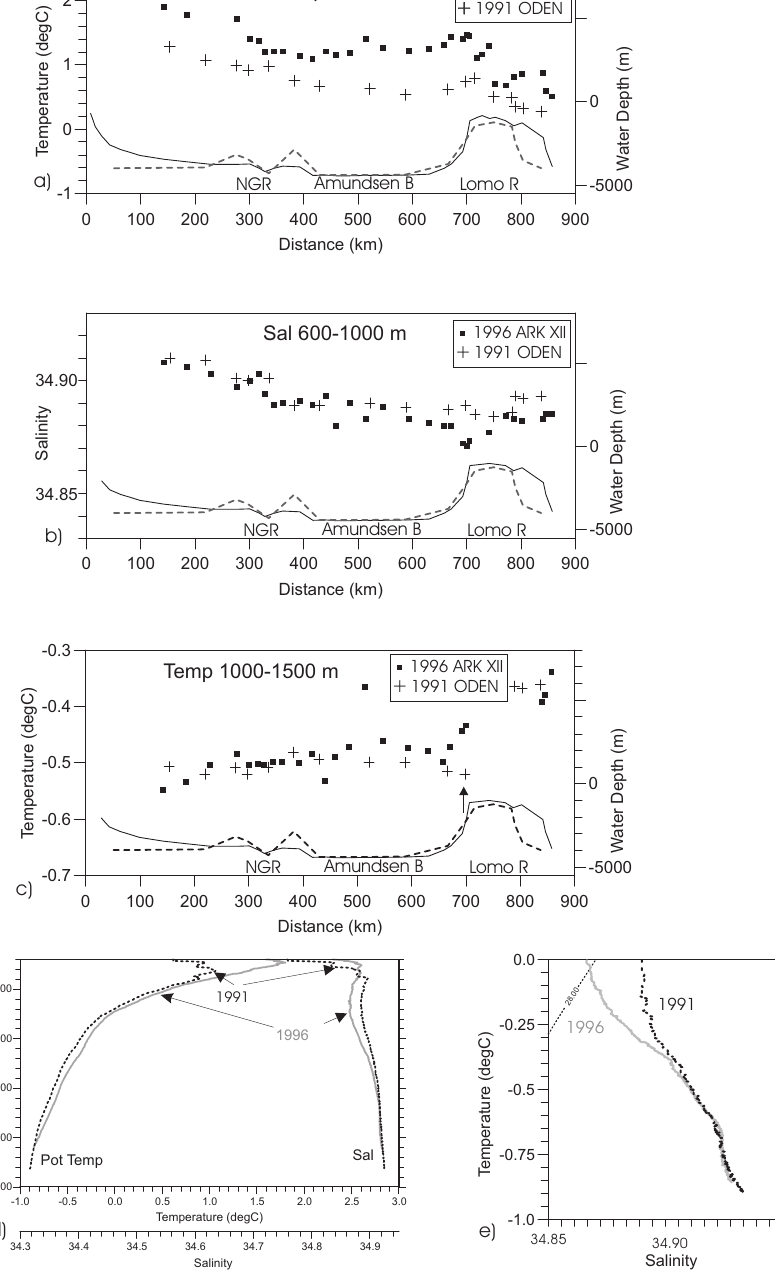
Fig. 15. Cross-basin distribution of vertically averaged values from the Nansen Gakkel Ridge (NGR) through the Amundsen Basin and over the Lomonosov Ridge (Lomo R) into the Makarov Basin along a section oc- cupied by Oden in 1991 and during ARKXII in 1996 (Fig. 1 for location): (a) temperature of the Fram Strait At- lantic layer (150–400m), (b) salinity of the core of the Barents Sea layer (600– 1000m), (c) temperature between 1000 and 1500m. At the bottom of each panel, the bottom topography along the two sections is given (Oden 1991: dot- ted line, ARK XII 1996: solid line). (d) Vertical profiles of potential tem- perature and salinity and (e) potential temperature vs. salinity at two stations at the western flank of the Lomonosov Ridge, noted by an arrow in